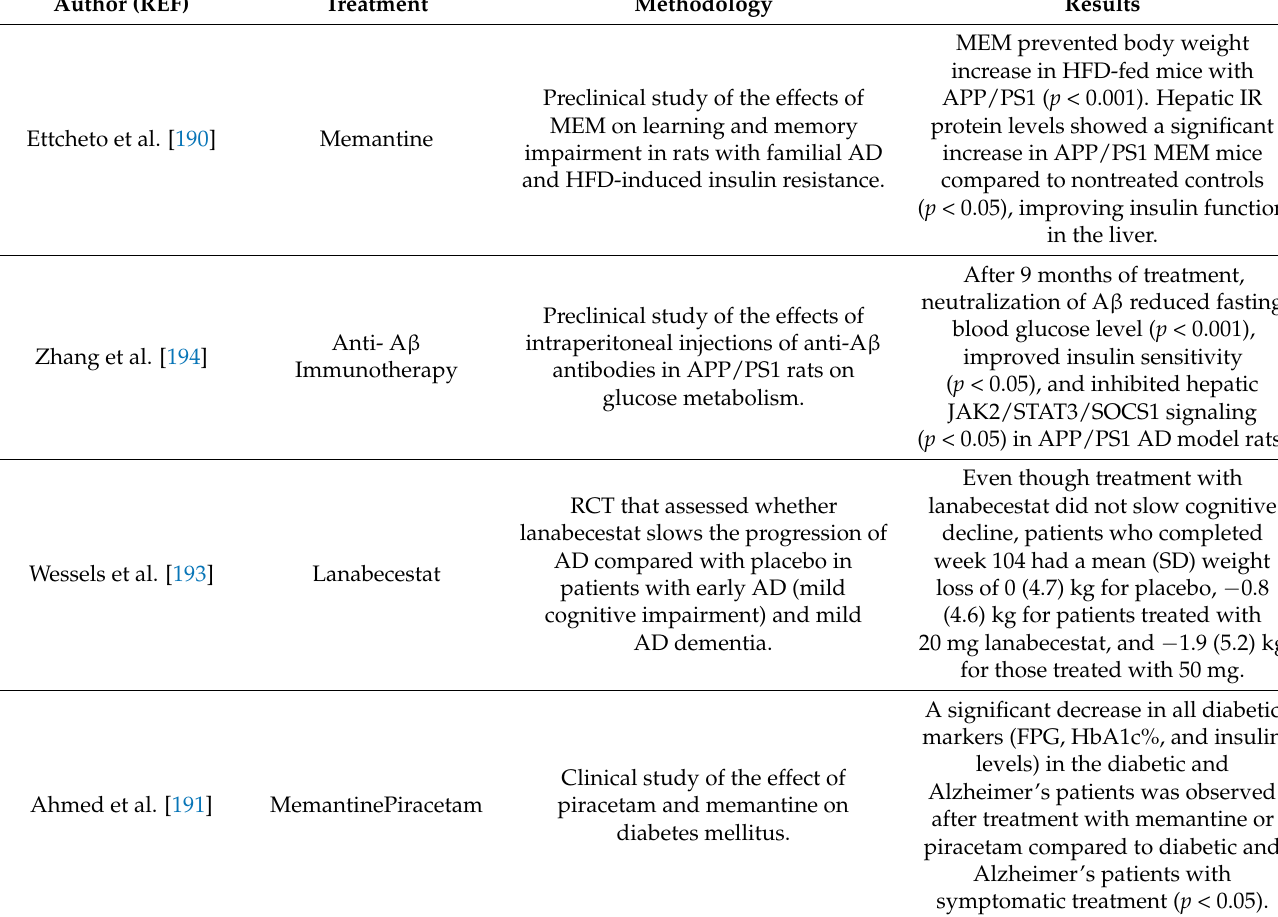
Table 4. Summary of preclinical and clinical studies exploring treatment of SM with anti-Alzheimer’s